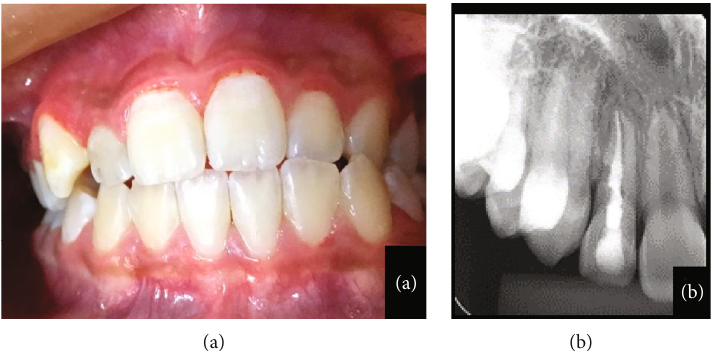
Figure 1: (a, b) Buccal gingival tissue of the maxillary lateral incisor reveals normal clinical features. Initial periapical radiography shows sealing material in the pulp cavity.